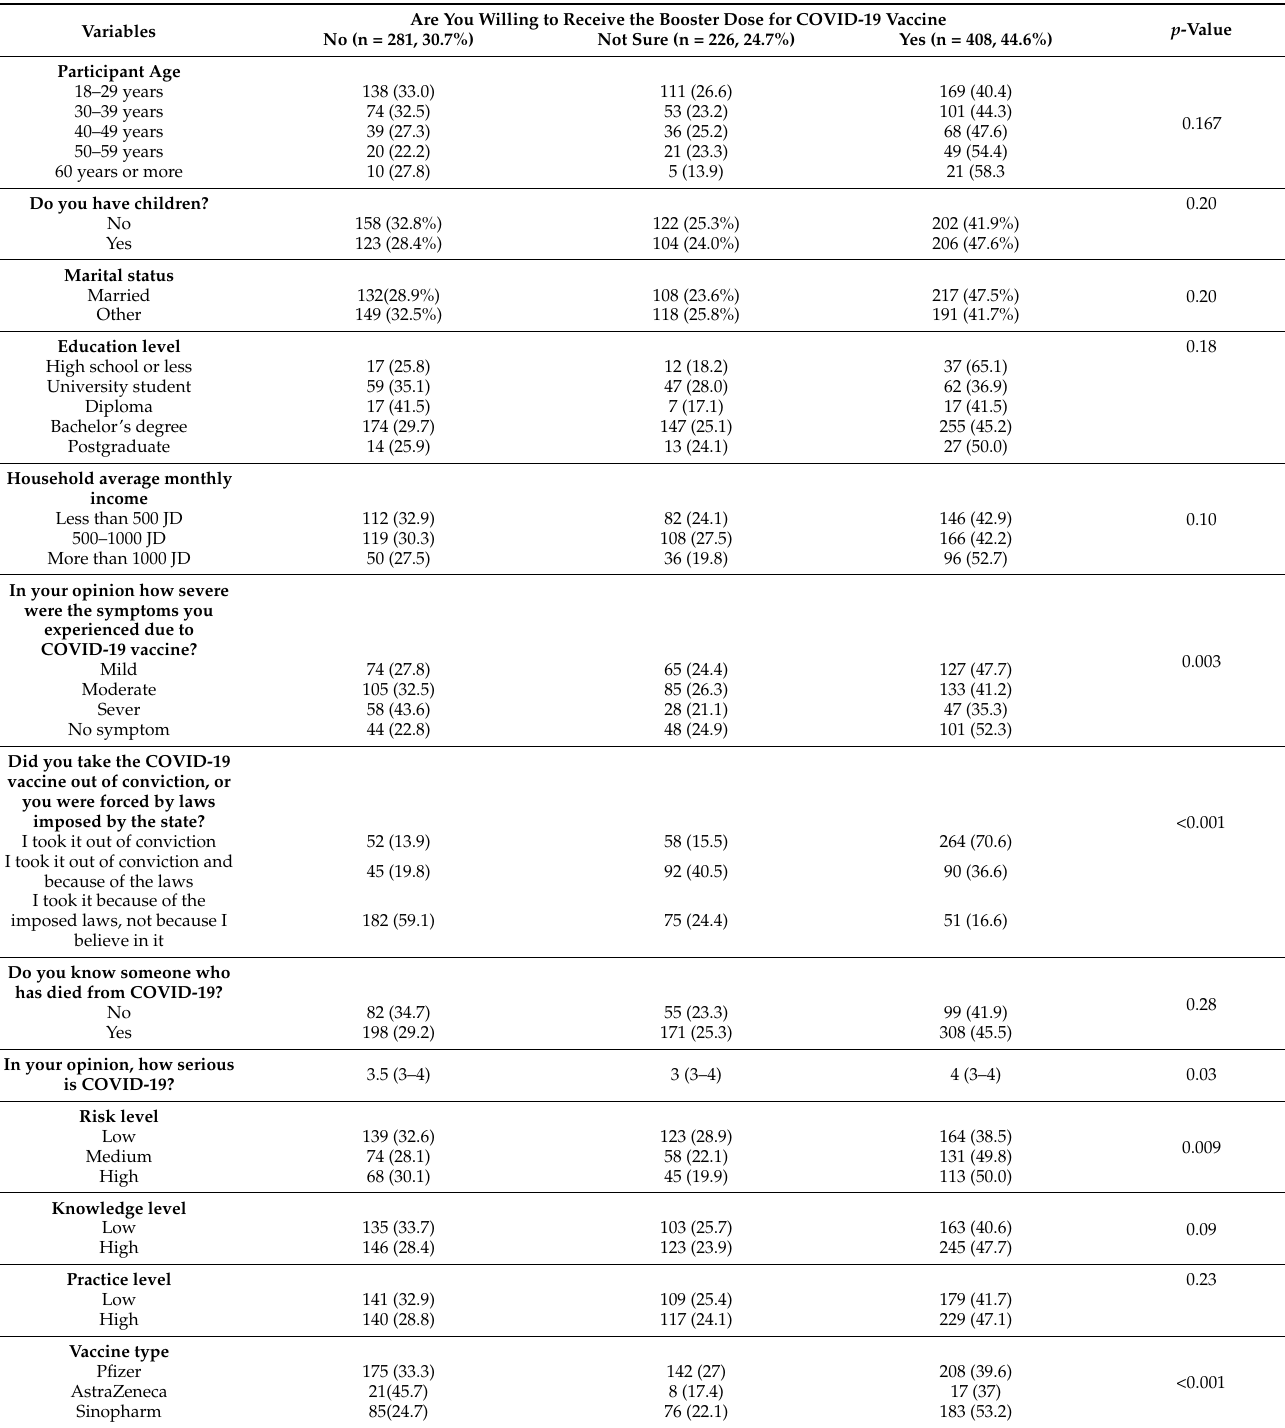
Table 2. Intent to get the booster dose of the COVID-19 vaccine by different sample characteristics presented as medians (25–75 quartiles) or frequencies